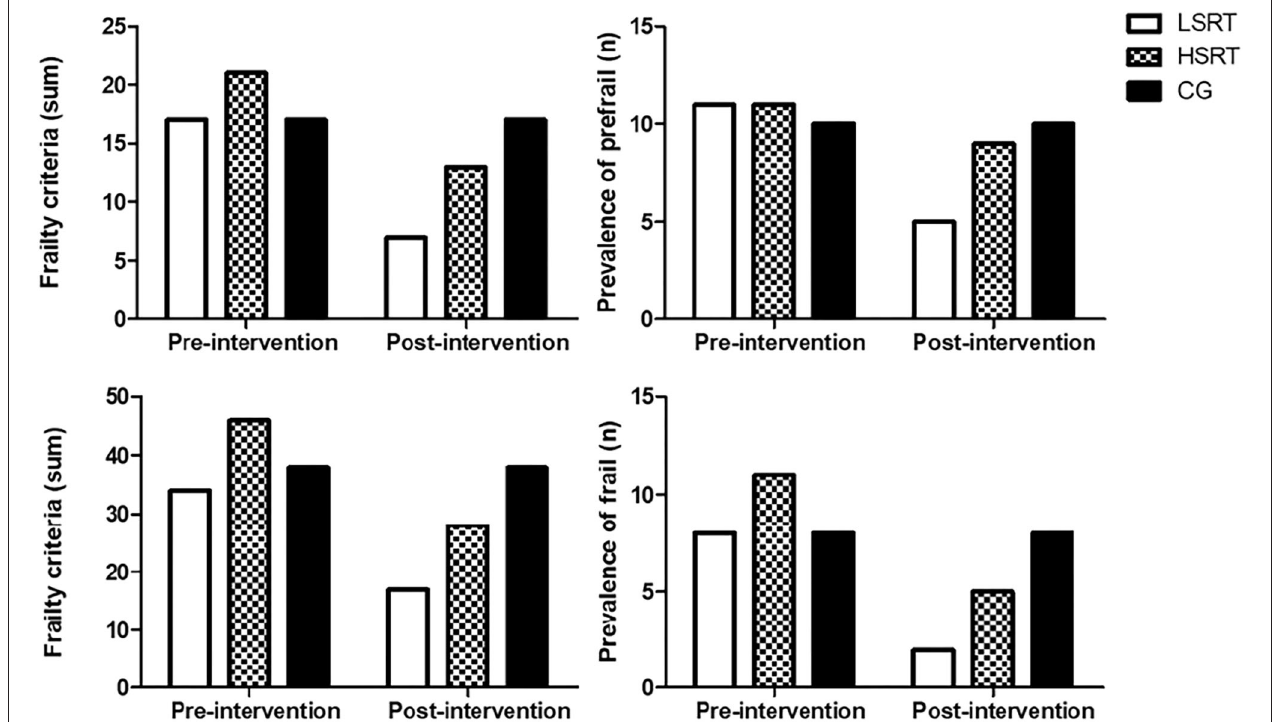
FIGURE 2 | Effects of RT on Frailty Status in prefrail and frail older adults. LSRT, Low-speed resistance training; HSRT, High-speed resistance training; CG, Control